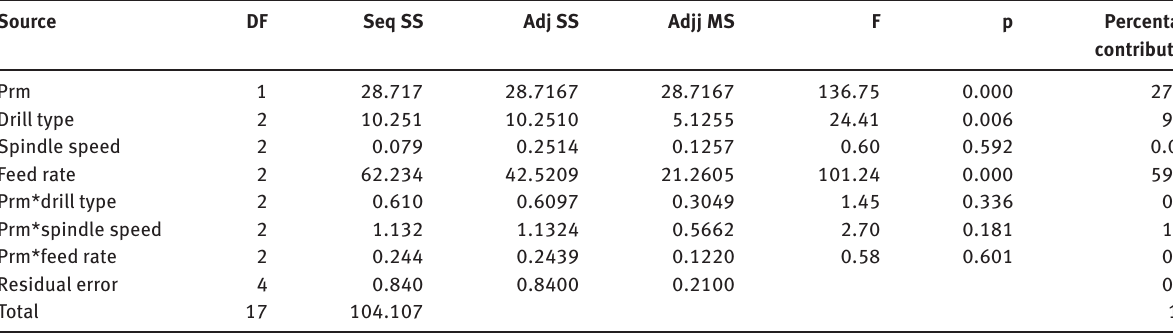
Table 8: ANOVA for S/N ratio for thrust